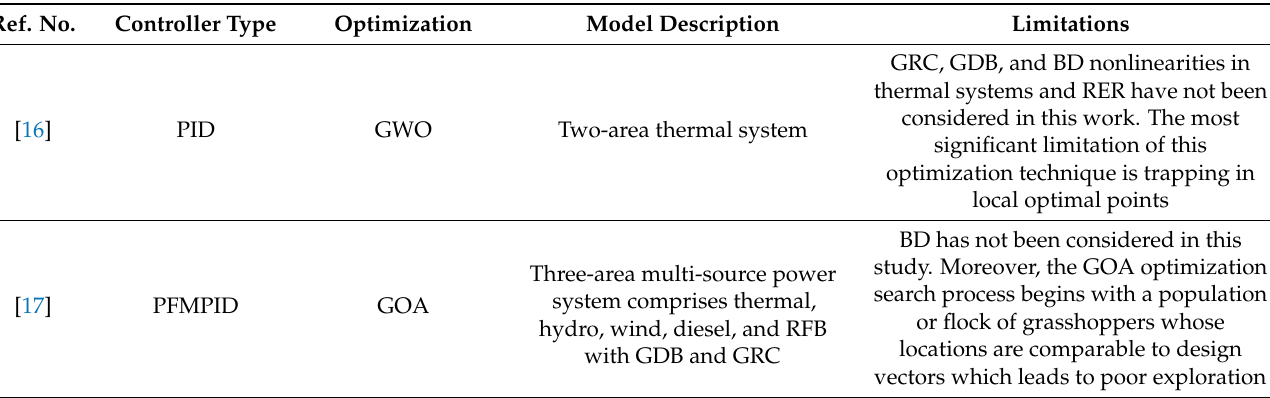
Table 1. Review of optimization algorithms used to study the